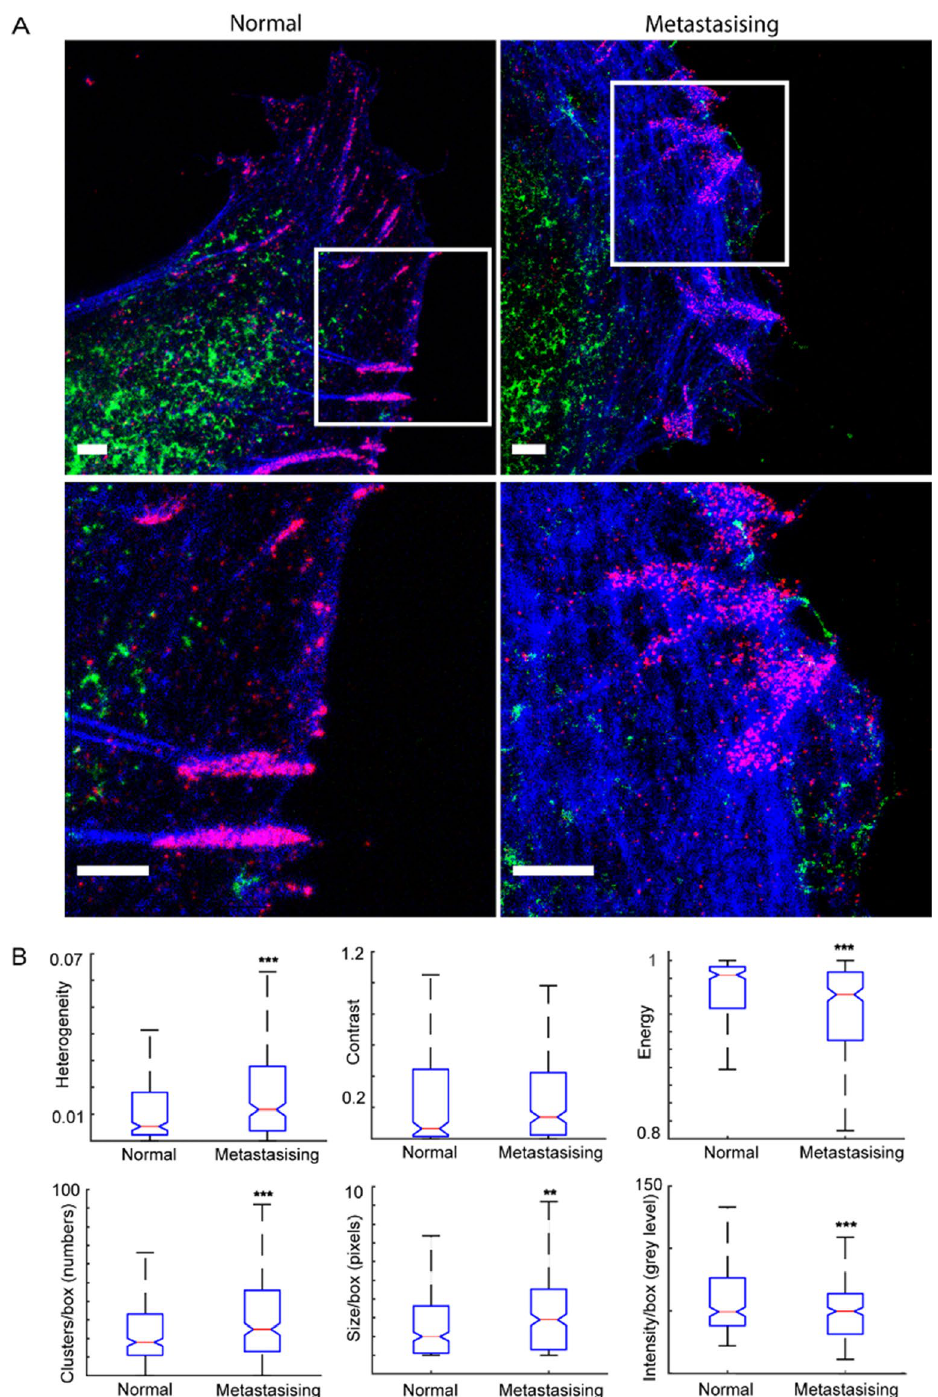
Figure 2. Nanoscale hyaluronan distribution in normal and invasive fibroblasts. ( A ) top panel, spatial distribution of hyaluronan (green), phosphotyrosines (red) and F-actin (blue) in control Bjhtert (left) and Bj-invasive (right) cells; lower panel, magnified boxed areas. ( B ) Notched box plots of hyaluronan features, thin red line showing median values. *** and ** indicates p < 0.001 and p < 0.01, respectively. Scale bars indicate 2